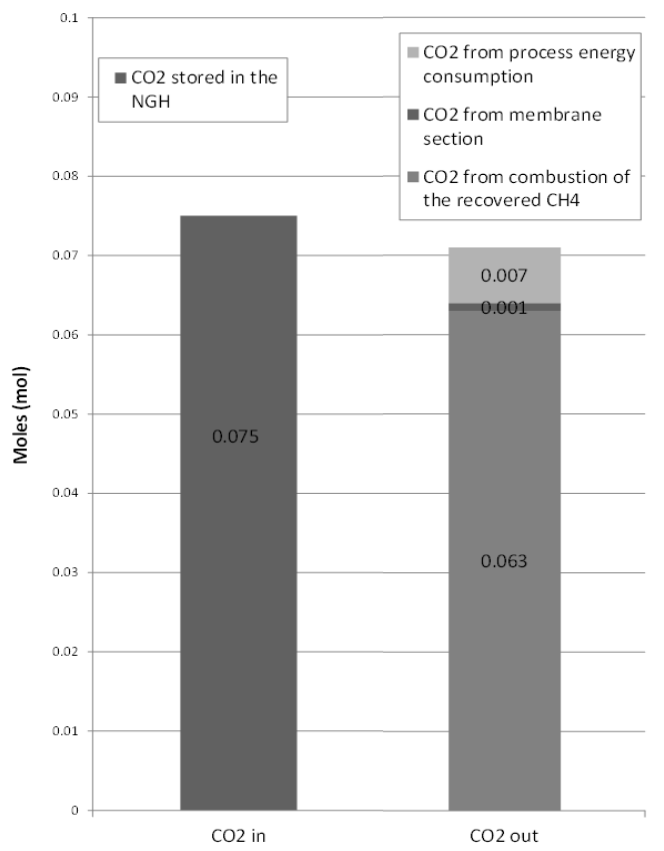
Figure 12. Carbon footprint of the process.